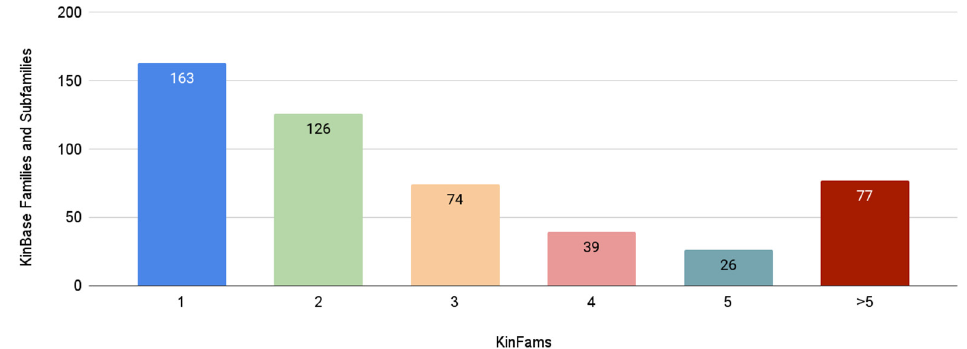
Figure 7. Mapping of KinBase to KinFams. The figure illustrates how many KinBase families and subfamilies are split into one or more KinFams by the FunFam-MARC protocol.